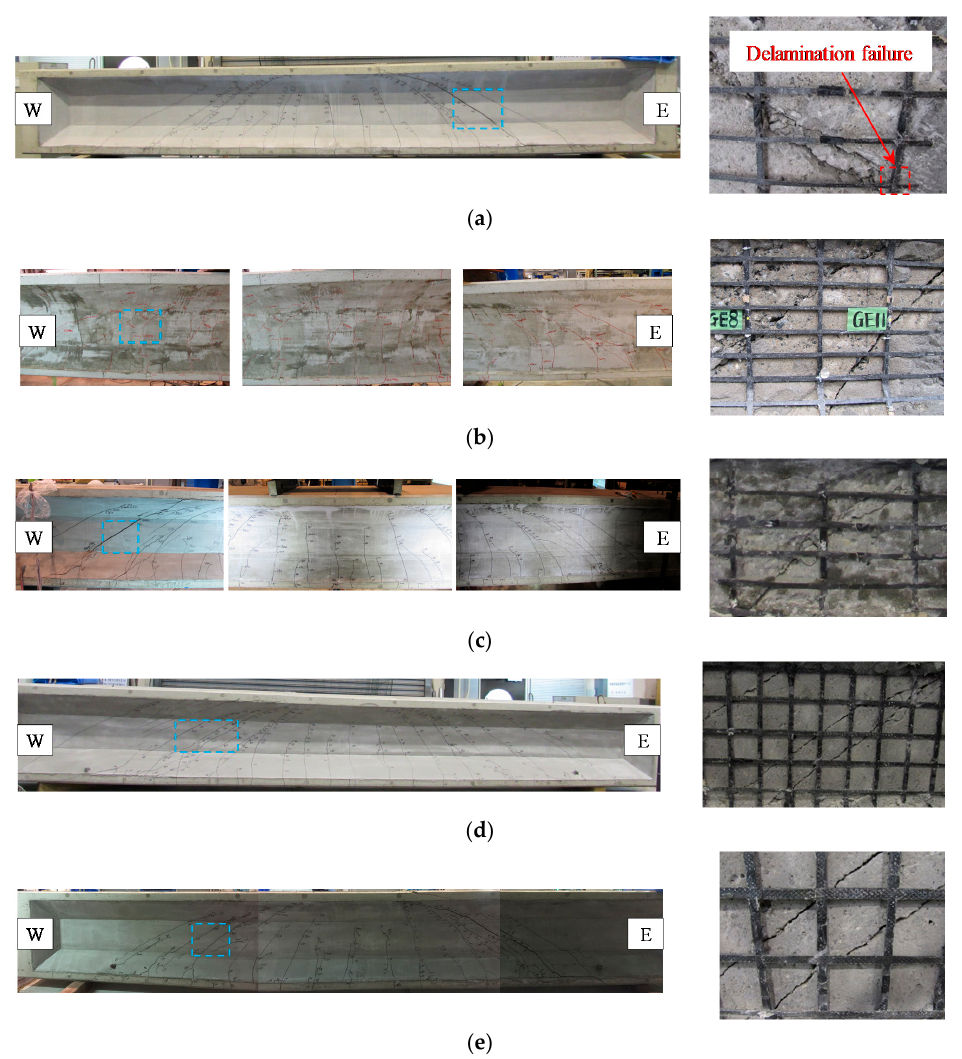
Figure 9. Crack patterns: ( a ) RHWC4; ( b ) RHWC6; ( C ) RHWC8; ( d ) RHWC4 (cid:48) ; ( e ) RHWC64. The pictures on the right correspond to the marked areas (blue dashed rectangle) on the specimens, showing the